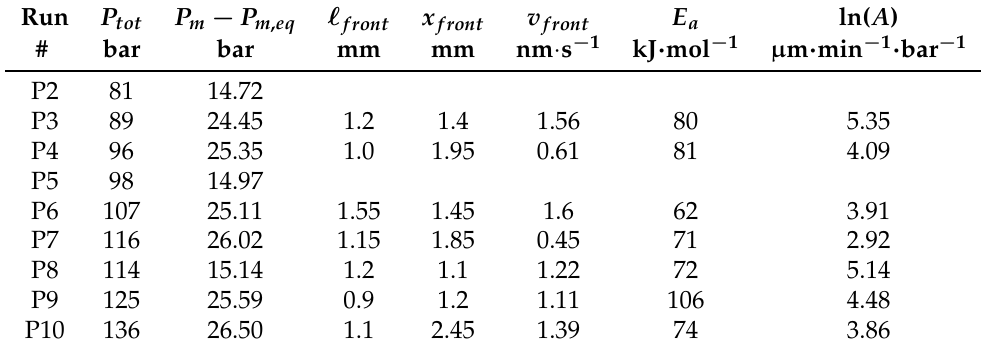
Table 6. Analysis of runs #P2–P10. Temperatures and pressures were obtained from the thermal mod- eling. Front width and velocity values were extracted from Figure 10 when possible. Activation ener- gies and pre-exponential factors were obtained from the previous data and Equations (18) and (19). Run P tot P m − P m ,